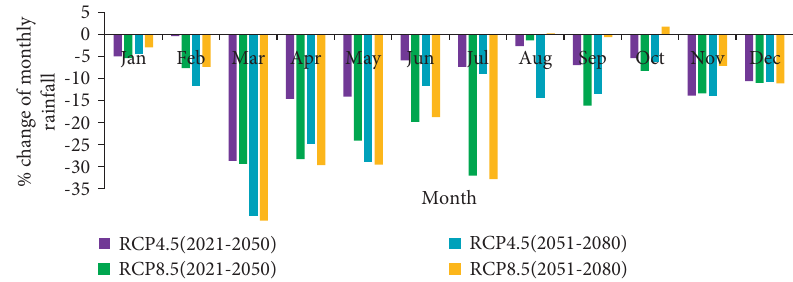
Figure 10: Change in average monthly rainfall over the period (2021–2050 and 2051–2080).